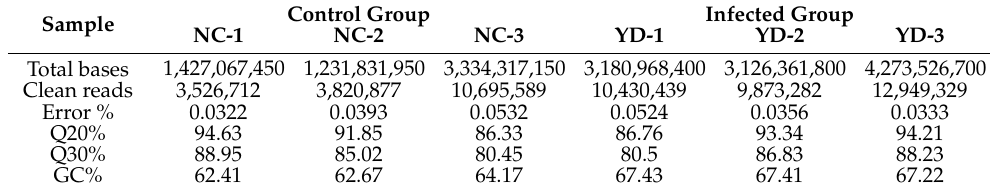
Table 2. sRNA high-throughput sequencing data.